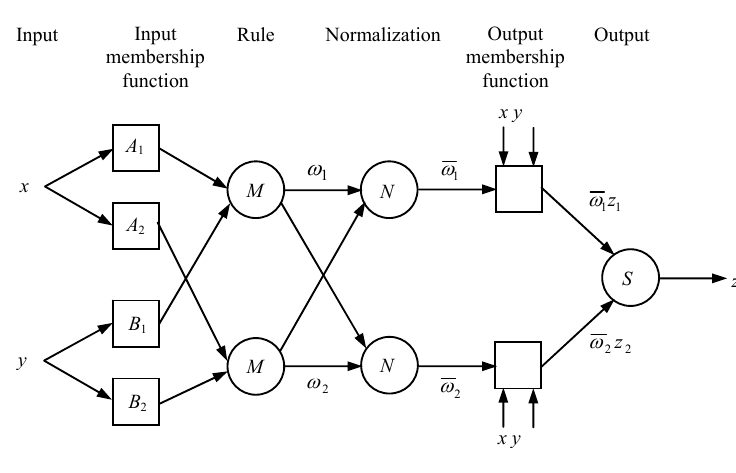
Figure 2. Architecture of the